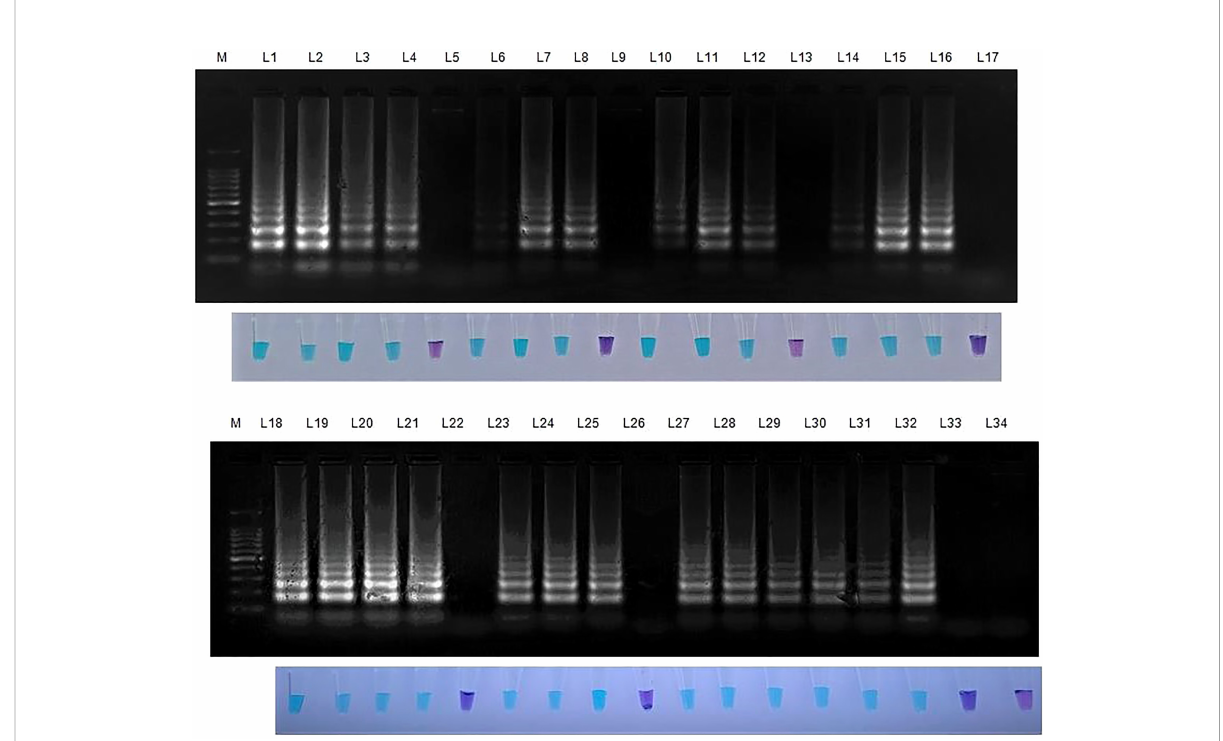
FIGURE 5 Validation of LAMP assay with S. oryzae infected fi eld samples. Bright sky blue colour represents positive reaction while the violet colour indicates the negative reaction. Upper panel in the fi gure shows agarose gel electrophoresis results whereas lower panel shows reaction tubes for colorimetric detection. M- 100bp Ladder; Lane 1: Sarocladium oryzae isolate OM841519 (Positive control); Lane 2: Coimbatore infected sheath sample 1; Lane 3: Coimbatore infected sheath sample 2; Lane 4: Coimbatore infected sheath sample 3; Lane 5: Coimbatore healthy sheath sample; Lane 6: Coimbatore infected seed sample 1; Lane 7: Coimbatore infected seed sample 2; Lane 8: Coimbatore infected seed sample 3; Lane 9: Coimbatore healthy seed sample; Lane 10: Villupuram infected sheath sample 1; Lane11: Villupuram infected sheath sample